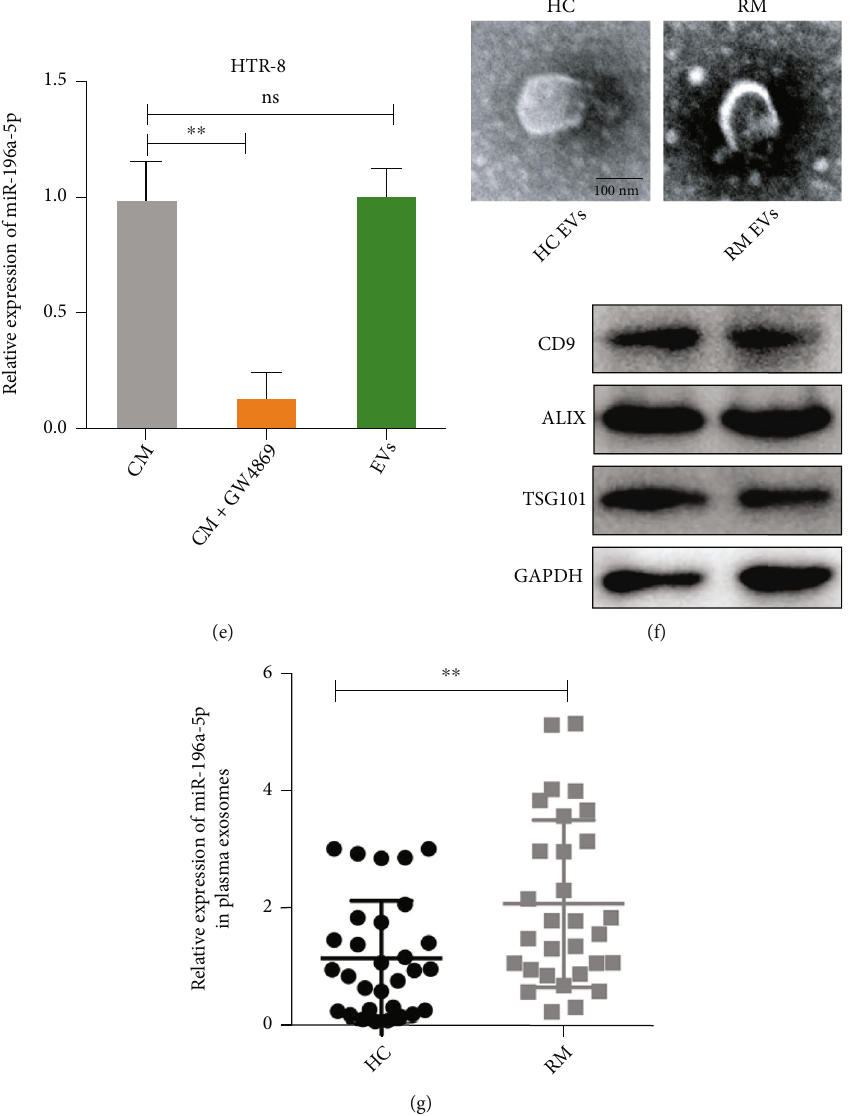
Figure 2: miR-196a is highly expressed in trophoblast-derived EVs and plasma EVs of RM patients. (a) qPCR analysis of the expression levels of miR-196a-5p in the nucleus, cytoplasm, and CM of the HTR-8 cell lines. (b) qPCR analysis of the expression levels of miR- 196a-5p in the CM of HTR-8 cells treated with RNase-A (2 mg/ml) alone or in combination with 0.1% Triton X-100. (c) Identi fi cation of the EVs derived from HTR-8 cells using transmission electron microscopy (top left), western blotting (bottom left), and NTA (right). (d) qPCR analysis of miR-196a-5p expression levels in the CM, CM with EVs removed by ultracentrifugation, and EVs of HTR-8 cells. (e) qPCR analysis of miR-196a-5p expression in the CM of HTR-8 cells treated with or without GW4869, an inhibitor of EV secretion, and in the EVs derived from the treated and untreated HTR-8 cells. (f) Identi fi cation of EVs isolated from the plasma of HC and RM patients through transmission electron microscopy (top) and western blotting (bottom). (g) qPCR analysis comparing the expression levels of miR-196a-5p in the plasma EVs of 30 RM patients and 30 HC individuals ( ∗ p < 0 : 05 ; ∗∗ p < 0 : 01 ; ∗∗∗ p < 0 : 001 ; ns: not signi fi cant). CM: culture medium; NTA: nanoparticle tracking